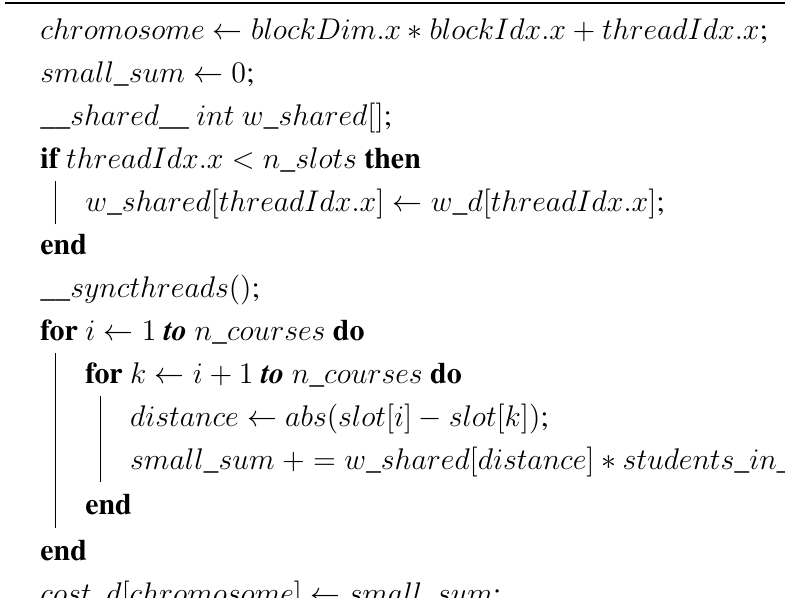
Algorithm 2: Evaluation, chromosome-threaded approach: each thread evaluates one chromosome of the